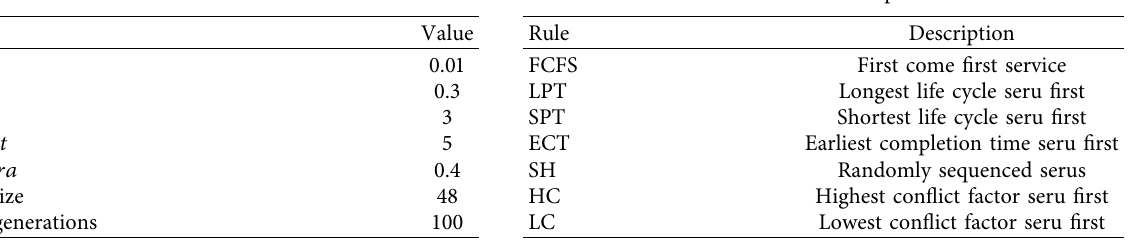
Table 3: Parameters for GP-SS. Table 4: Seven rules to be compared with